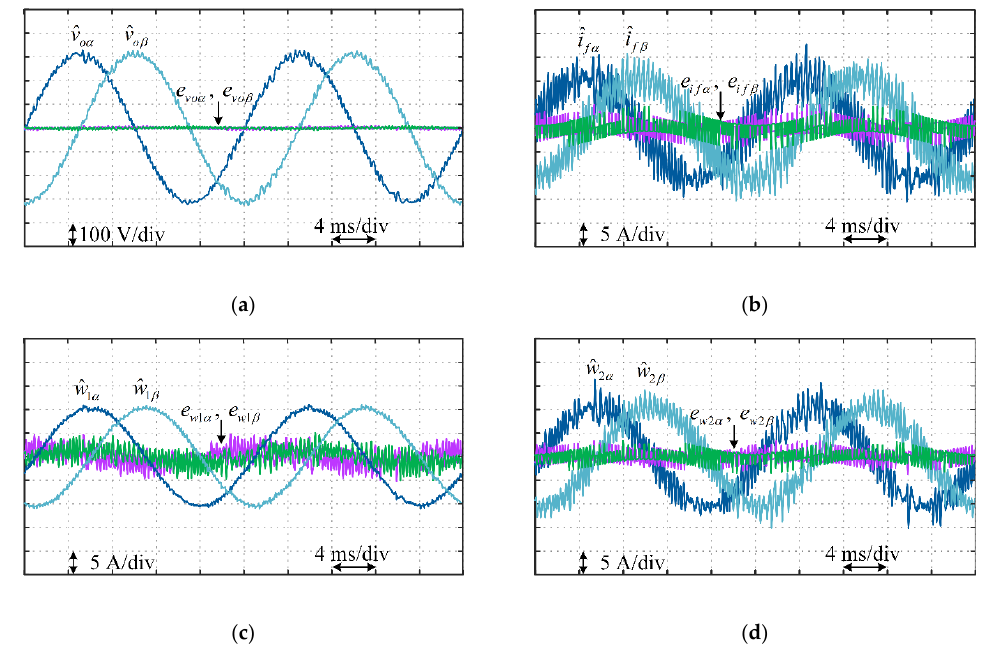
Figure 7. Simulation results showing outputs of the proposed adaptive observer under nominal load (5 kW) and 75% error in the initial value of filter capacitance ( e C = 75%), ( a ) estimated capacitor voltages and voltage estimation errors ( b ) estimated inverter currents and current estimation errors, ( c , d ) estimated disturbance inputs and disturbance estimation errors.